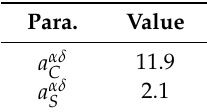
Table 3. Values for cuboid box model parameters (unit: nm/s 2 ).